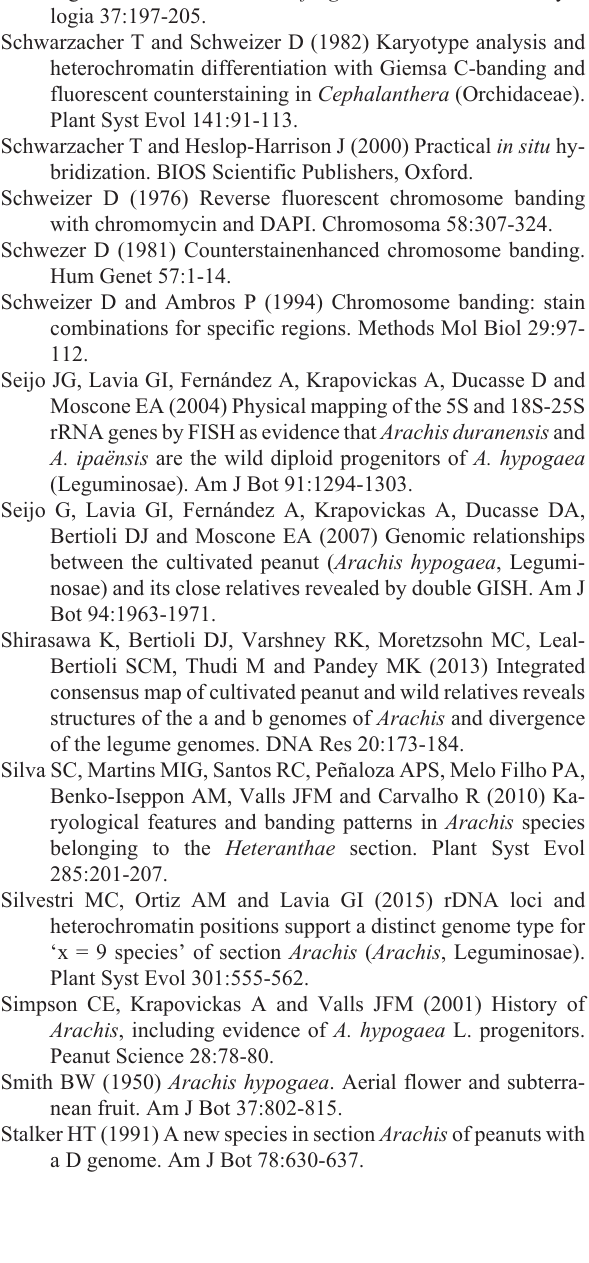
Figure S1: Double GISH showing similar labeling patterns in chromosomes of Xingu/Nambikwara of 115. Figure S2: Double GISH showing similar labeling patterns in chromosomes of Xingu/Nambikwara Of 115. Figure S3: Matrix representing the genetic distance among in pairwise comparisons. Table S1: Genotyping of Arachis accessions using A. steno- sperma specific